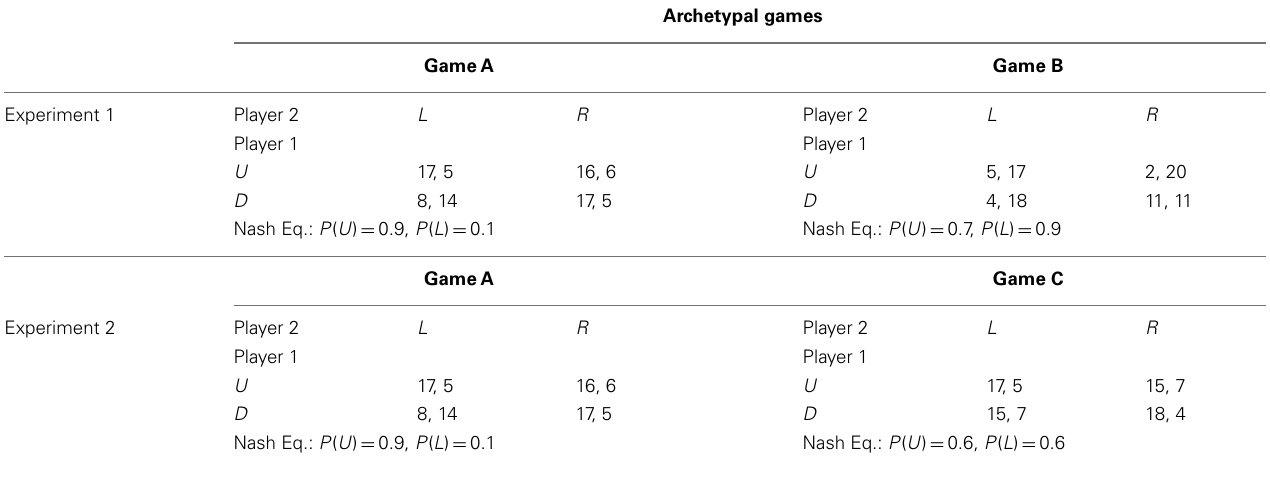
Table 1 |The two pairs of completely mixed archetypal games used for building the game sequences in the two